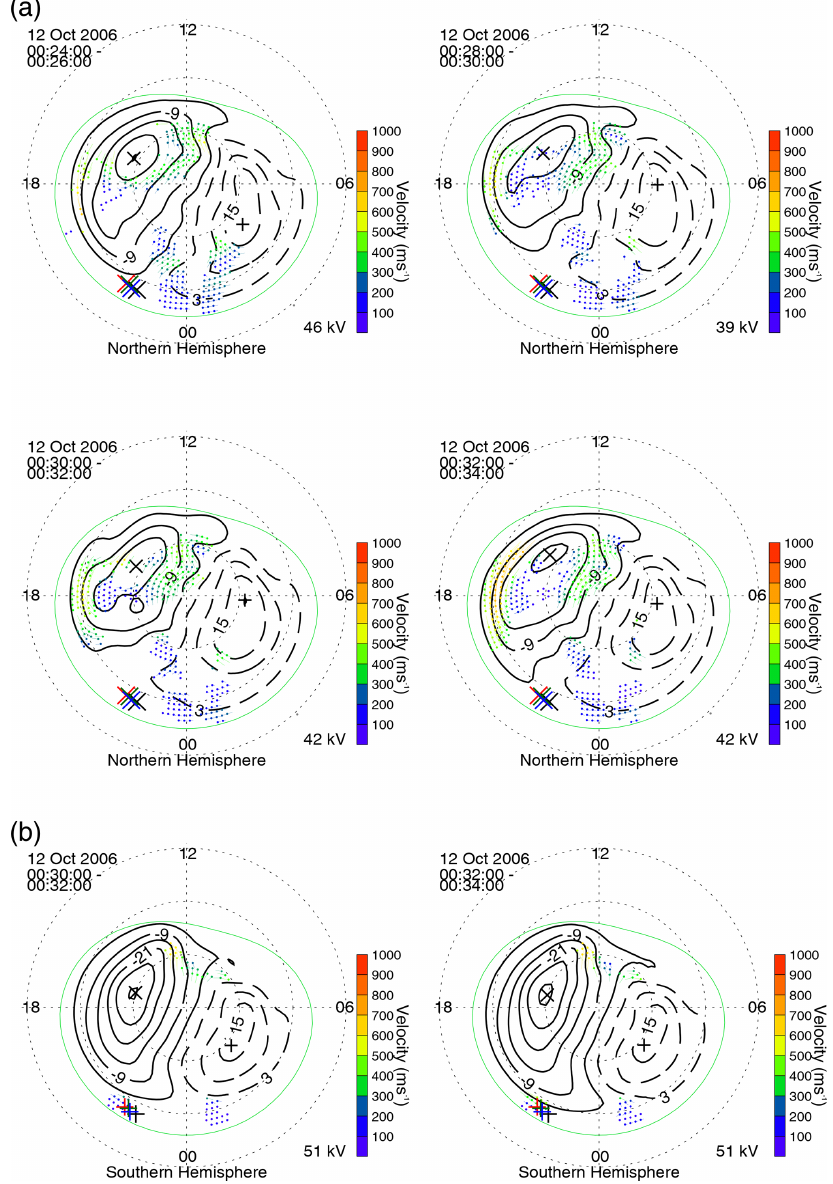
Figure 4. Maps of the ionospheric plasma convection derived from SuperDARN observations. Midnight is to the bottom of each map, noon to the top, dusk to the left and dawn to the right. The dashed black circles are spaced every 10 ◦ in magnetic latitude. The thicker solid and dashed black lines represent the plasma streamlines and are the contours of the electrostatic potential. Flow vectors are plotted at the locations of radar observations, and these are colour-coded based on the magnitude of their velocity. (a) Four 2min northern hemisphere maps from 00:24–00:26, 00:28–00:30, 00:30–00:32 and 00:32–00:34UT, respectively. (b) Two 2min southern hemisphere maps from 00:30– 00:32 and 00:32–00:34UT, respectively. On each northern (southern) hemisphere map, the footpoints of the Cluster spacecraft constellation are shown by the X’s ( + ’s), mapped using the TA15